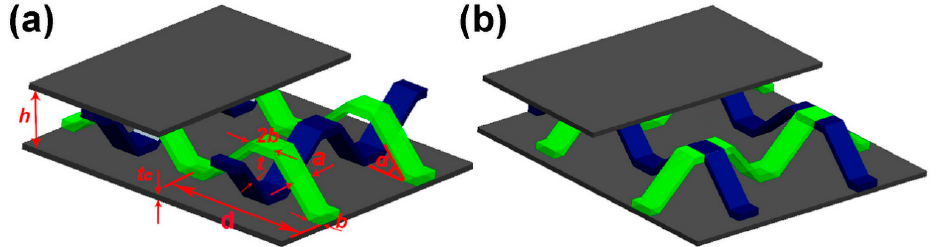
Figure 2. ( a ) Bi-directional corrugated lattice structure (I), ( b ) Pyramidal lattice structure (II).